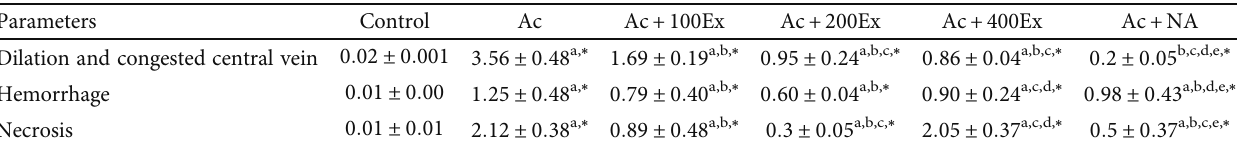
Figure 3: Histopathological of liver tissue sections in di ff erent study groups. Liver tissue sections in di ff erent studied groups; CV: central vein; blue arrows: hepatocyte necrosis; red arrow: hemorrhage; H&E staining, × 400 magni fi cation. Table 3: Grading of pathological liver tissue lesions in the tested